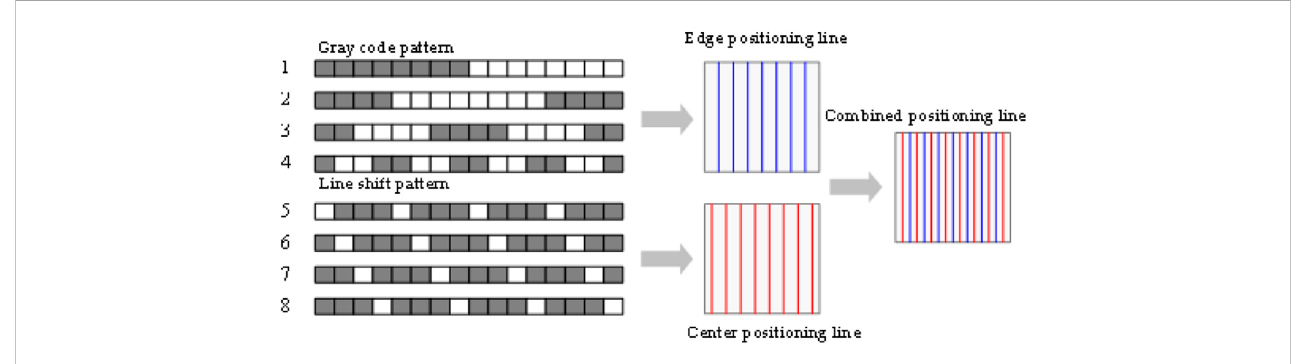
FIGURE 2 Principle of encoding and decoding by stripe edge and four-step line